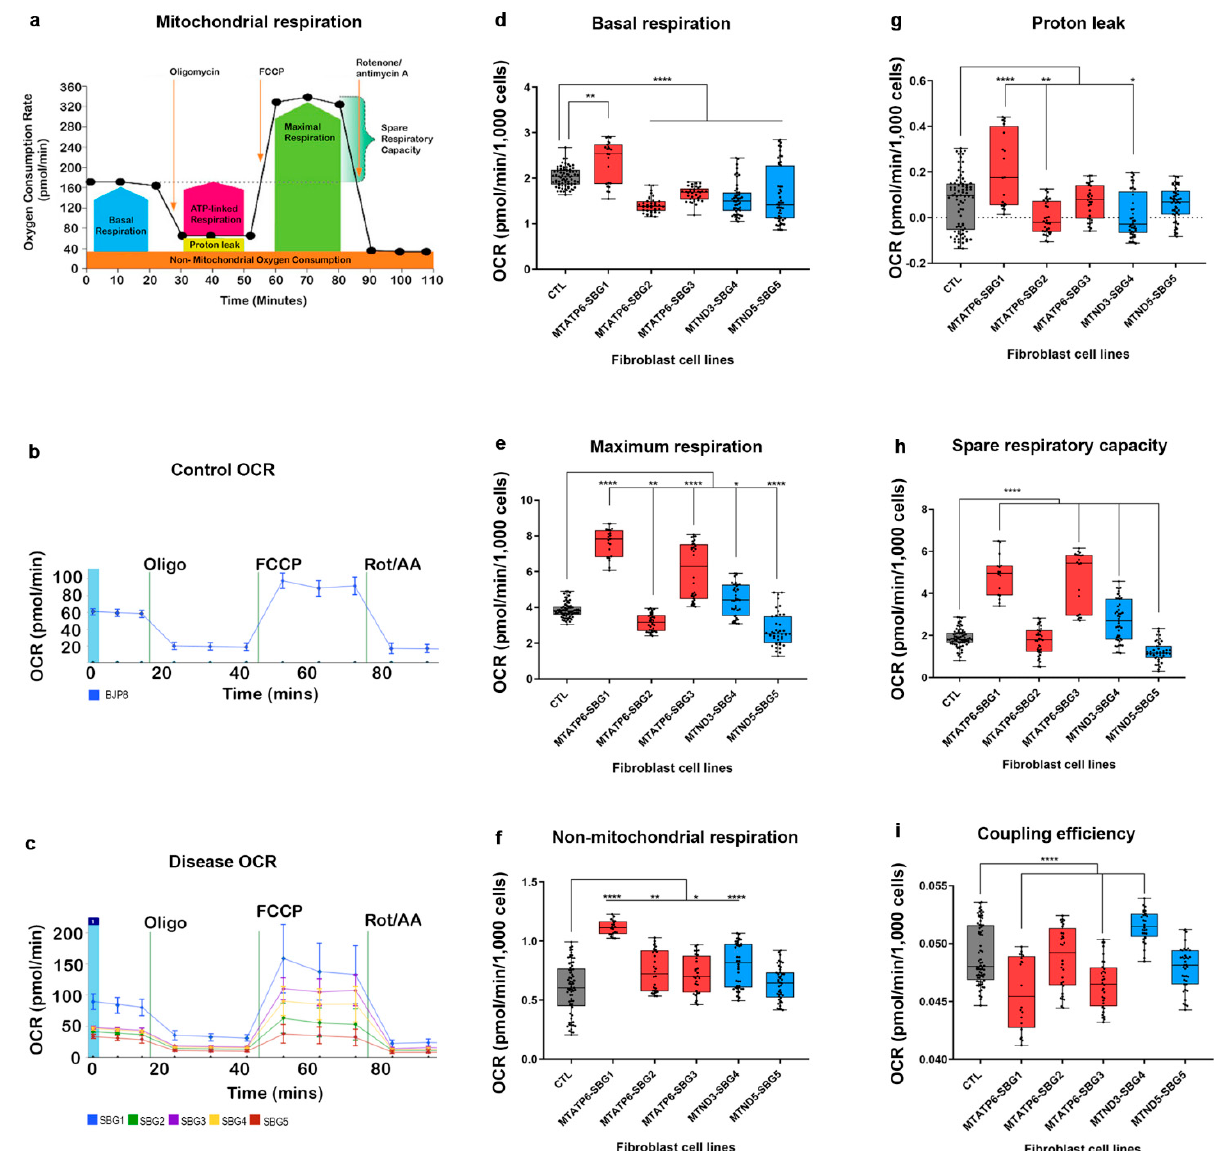
Figure 1. Mitochondrial respiratory profile of CTL BJ-FB and five LS fibroblast cell lines. ( a ) Scheme of expected oxygen consumption rate (OCR) under basal conditions, ( b ) representative OCR profile of BJ-FB, ( c ) representative OCR profile of diseased SBG1-FB ( MT-ATP6-T8993G ), SBG2-FB ( MT-ATP6-T8993G ), SBG3-FB ( MT-ATP6-T9185C ), SBG4-FB ( MT-ND3-T10158C ) and SBG5-FB ( MT-ND5-T12706C ) cell lines showing ( d ) basal respiration, ( e ) maximal respiration ( f ) non-mitochondrial respiration after Rot/AA injection proton leak, ( g ) proton leak ( h ) spare respiratory capacity, ( i ) coupling efficiency. All parameters are in pmol/min/1000 cells. Data are mean +/- SD. Experiments were repeated at least three times on different days under the same conditions. * p < 0.05 ** p < 0.01 **** p < 0.0001. Comparative analyses for all diseased (SBG1-5) FBs were conducted with the healthy control BJ-FB line.